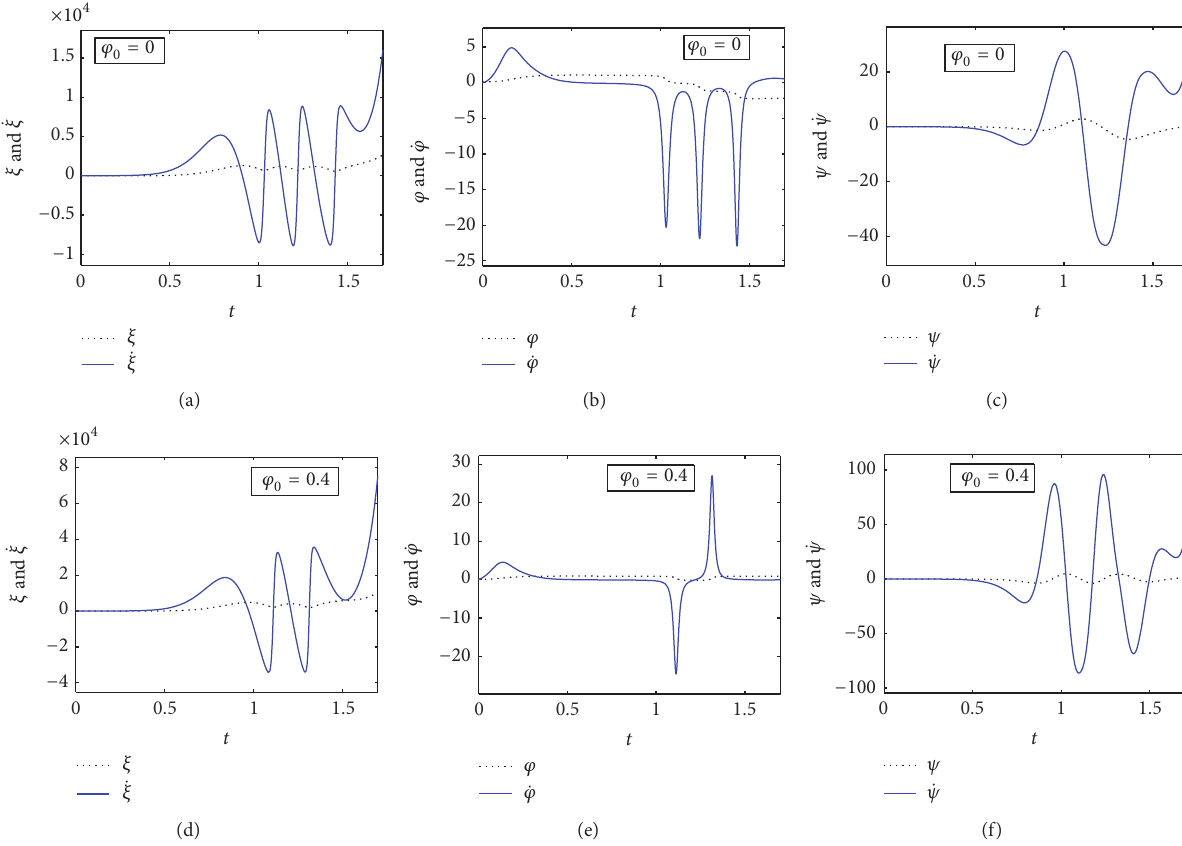
Figure 2: Variation of the solutions and their derivatives versus time 𝑡 when 𝑏 = 3 m, ℎ = 4.5 , and 𝑎 = 0.5 m: (a, d) show the effect of 𝑡 on the ̇𝜉 behavior of 𝜉 and waves when 𝜑 0 = 0 and 𝜑 0 = 0.4 rad, respectively, (b, e) show the effect of 𝑡 on the behavior of 𝜑 and ̇𝜑 waves when 𝜑 0 = 0 and 𝜑 0 = 0.4 rad, respectively, and (c, f) show the effect of 𝑡 on the wave that describes the behavior of 𝜓 and ̇𝜓 when 𝜑 0 = 0 and 𝜑 0 = 0.4 rad,